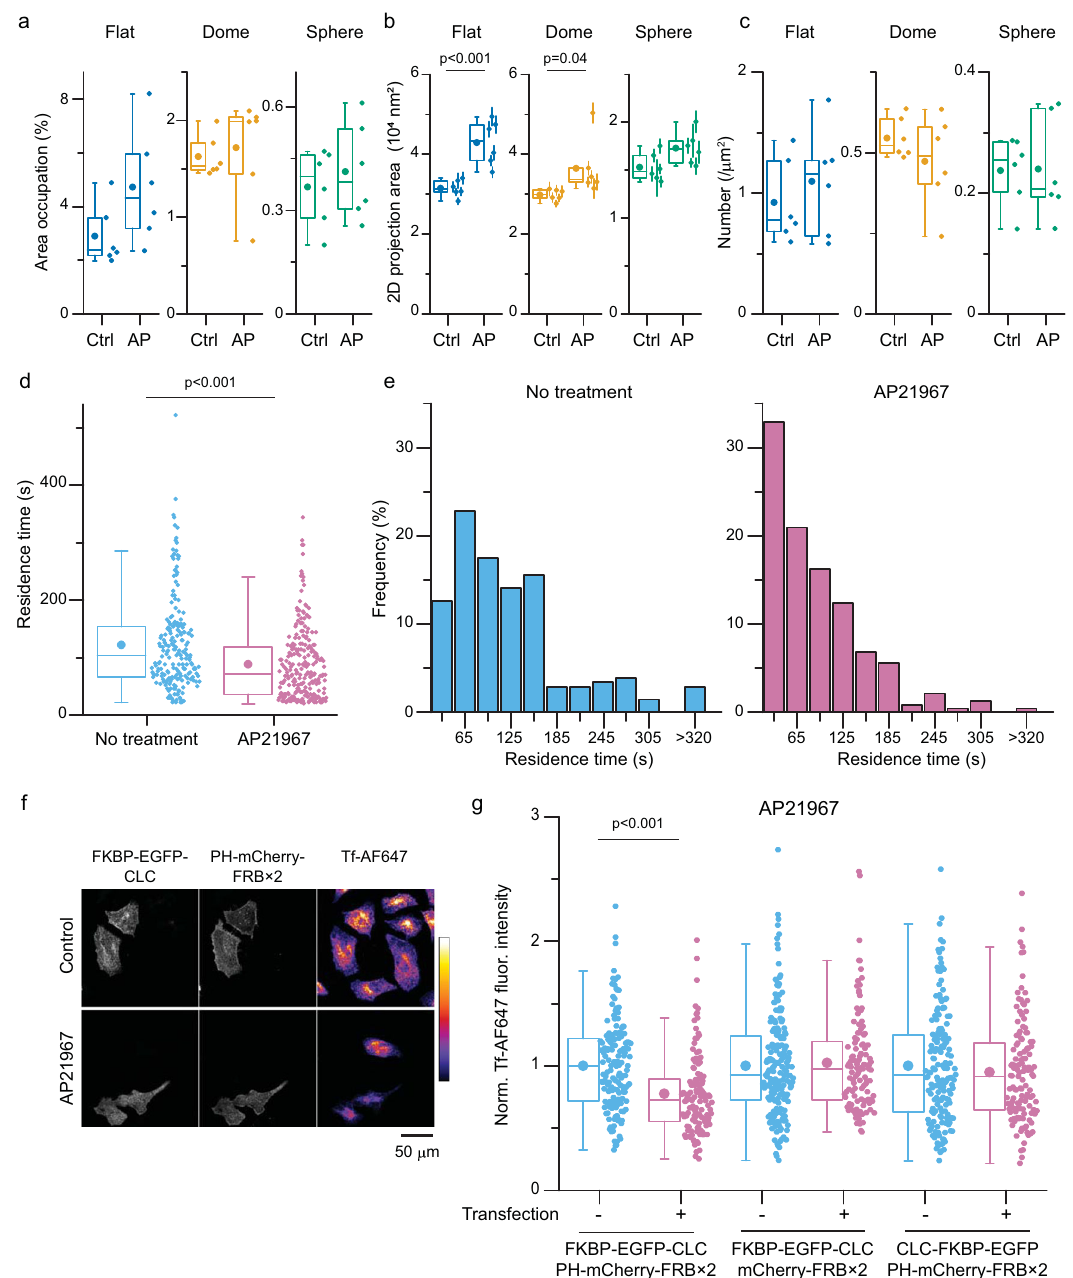
Fig. 5 | Manipulation of CLC conformation changed lattice structures, dynamics, and endocytosis. a – c Unroofed membranes from cells expressing FKBP-EGFP-CLC and PH-miRFP-FRB×2 treated with AP21967 (AP) or ethanol (con- trol) were imaged with PREM. Two-dimension area of single CCS were manually segmented and measured. Membrane area occupation against the total analyzed membrane area ( a ), two-dimension projection area ( b ), and density ( c ) of fl at, domed,andsphereCCSswerecompared.Eachdotisfromonecellexperiment,and errors are SE. n =6 cells from 3 experiments for each condition. The average measured area / cell (mean±SE)=213±34 (control) and 165±10 μ m 2 (AP21967). d Live cell time lapse TIRF imaging on HeLa cells expressing FKBP-EGFP-CLC and PH-miRFP-FRB×2 without or with AP21967 treatment. Tracks with over 20s were analyzed and residence times were compared. n =206 spots from 5 cells from 3 experiments (no treatment) and 234 spots from 5 cells from 4 experiments